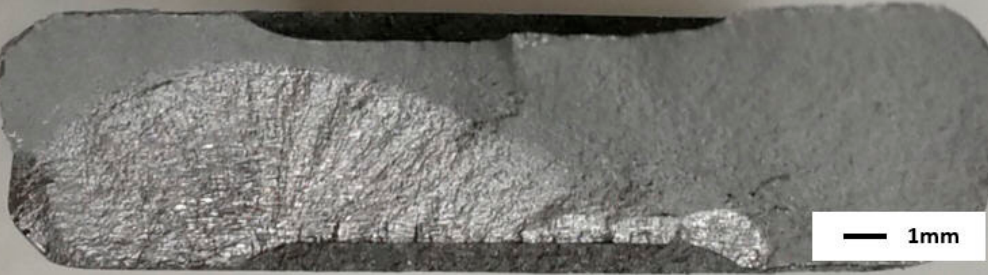
Figure 17. Failure surface associated with AMC LT-NGB 1, failed at 54,801 cycles.